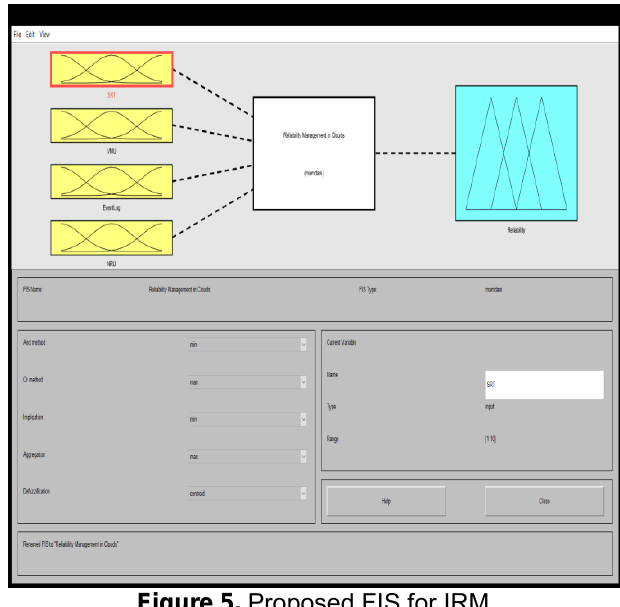
Figure 5. Proposed FIS for